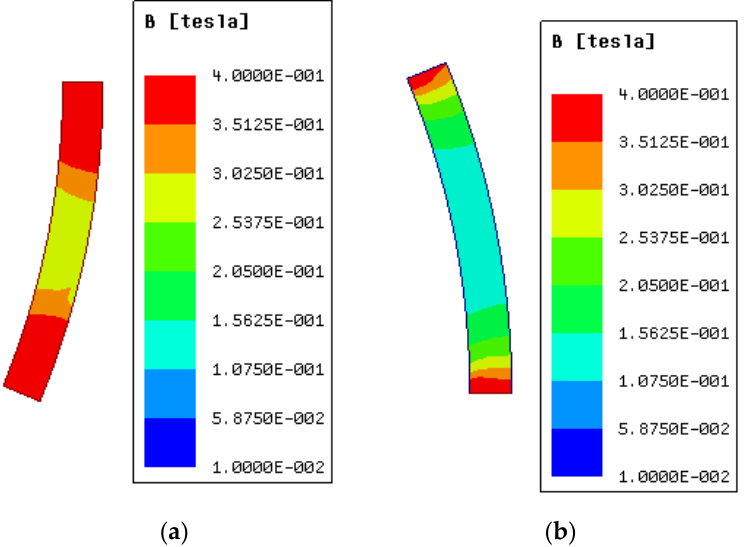
Figure 13. Demagnetization indicated by flux densities of RE-FRG structure when the temperature variation: ( a ) at 20 (cid:2925) C , PF = 0.89; ( b ) at 120 (cid:2925) C , PF = 0.59.